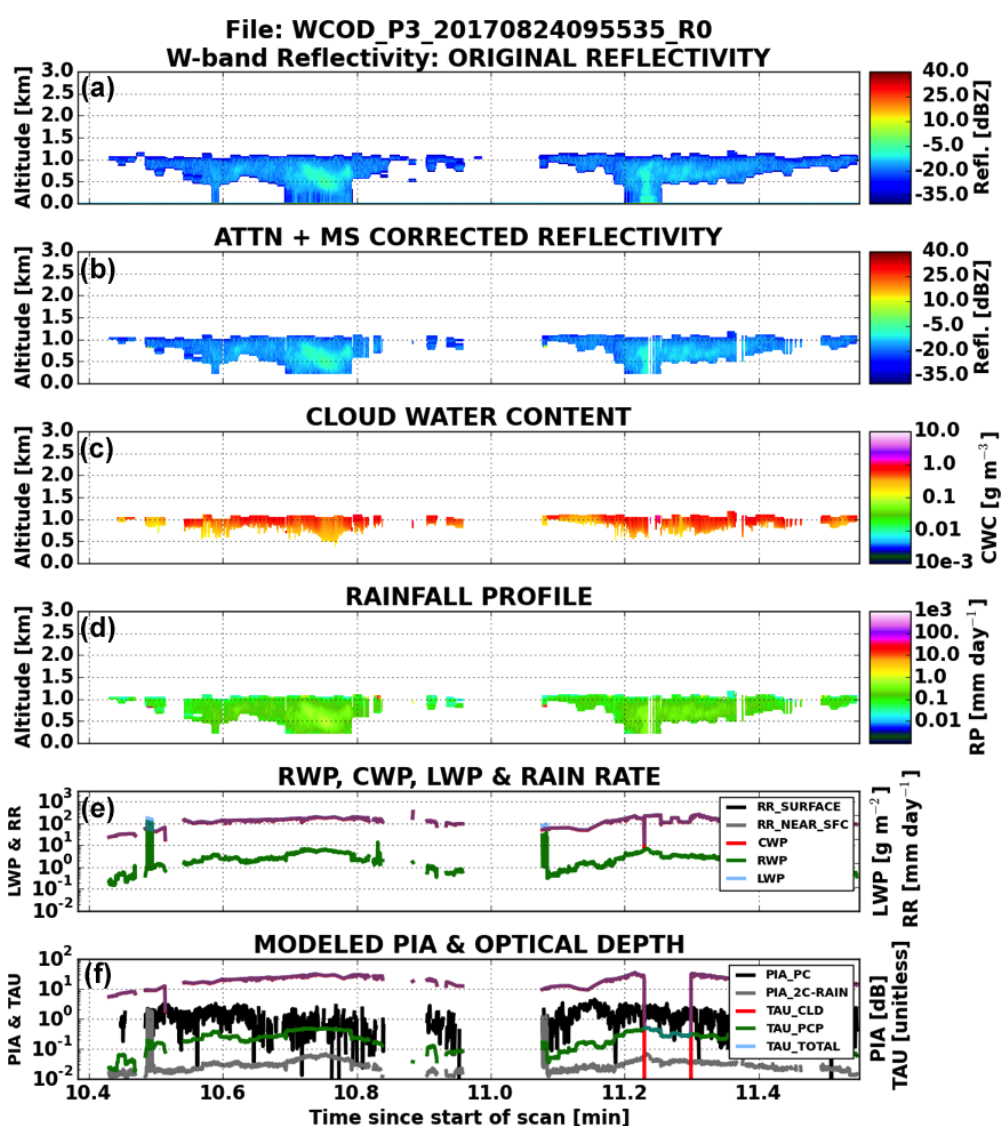
Figure 2. WCOD retrieval for a pair of lightly drizzling stratocumulus clouds observed by the APR-3 (a) on 24 August 2017. The model- corrected reflectivity (b) for this scene, along with retrieved RWC (c) and rainfall profile (d) , is also shown. The bottom two panels (e, f) show retrieved water paths (cloud, rain, and total), rainfall rates (surface or evaporation-corrected rainfall rate and near-surface rainfall rate), attenuation (“PC” or observed and “WCOD” or modeled), and optical depths (cloud, rain and total). The lower LWP and optical depth values around minute 10.5 correspond to a short period where the RSP was not